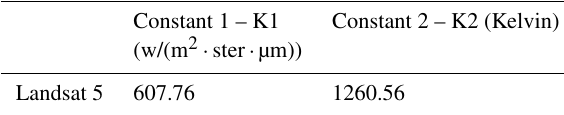
Table 2. TM thermal band calibration constants.